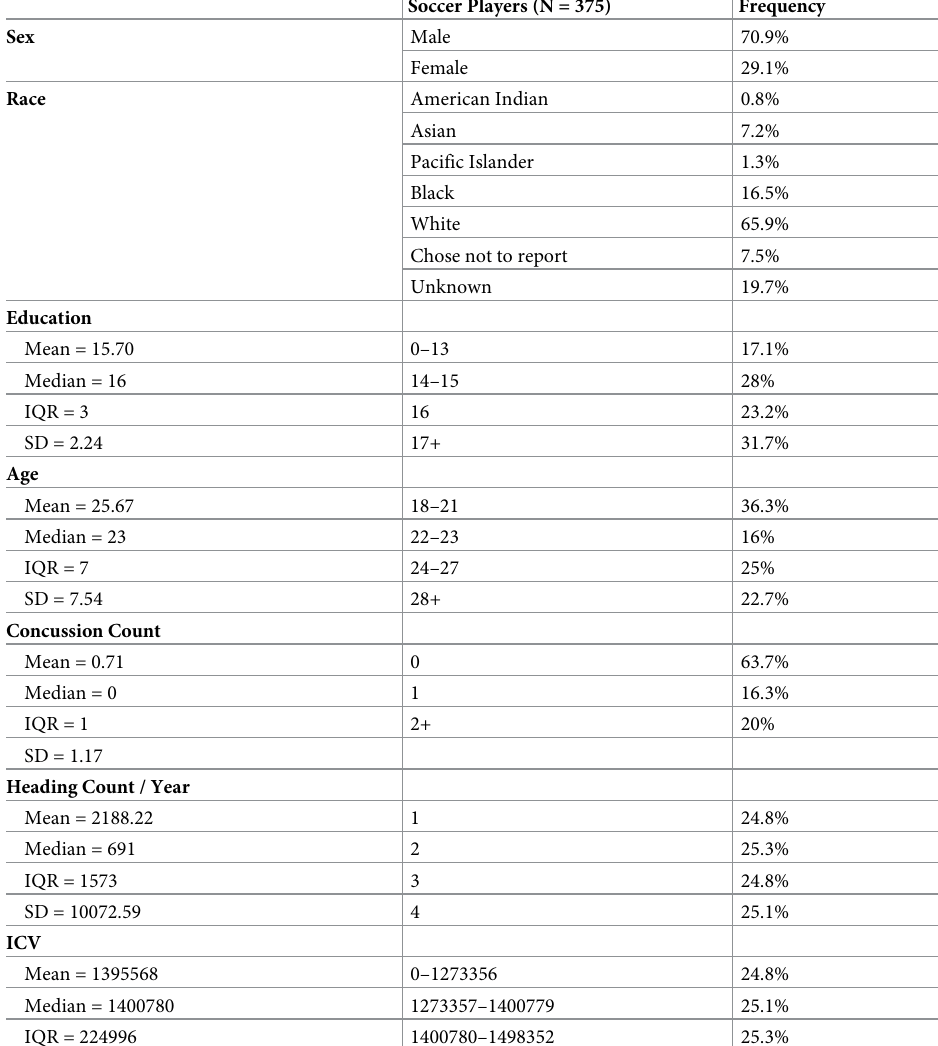
Table 1. Demographic characteristics of 365 amateur soccer